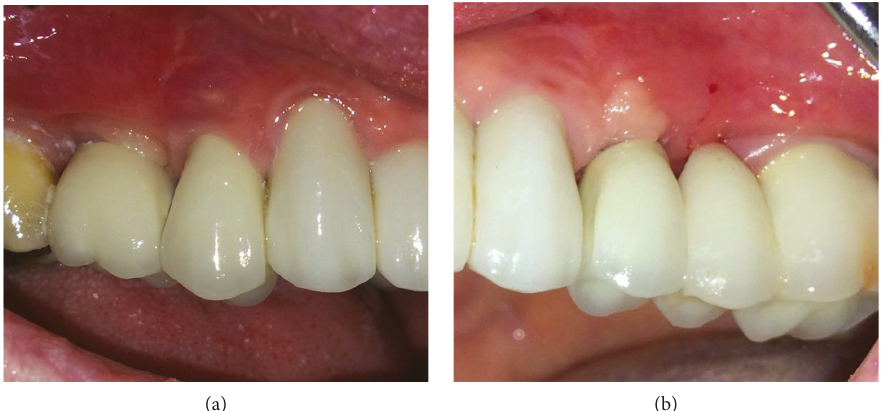
Figure 3: Prosthetic crowns immediately after cementation on the abutments. (a) Right side of the maxilla. (b) Left side of the maxilla.